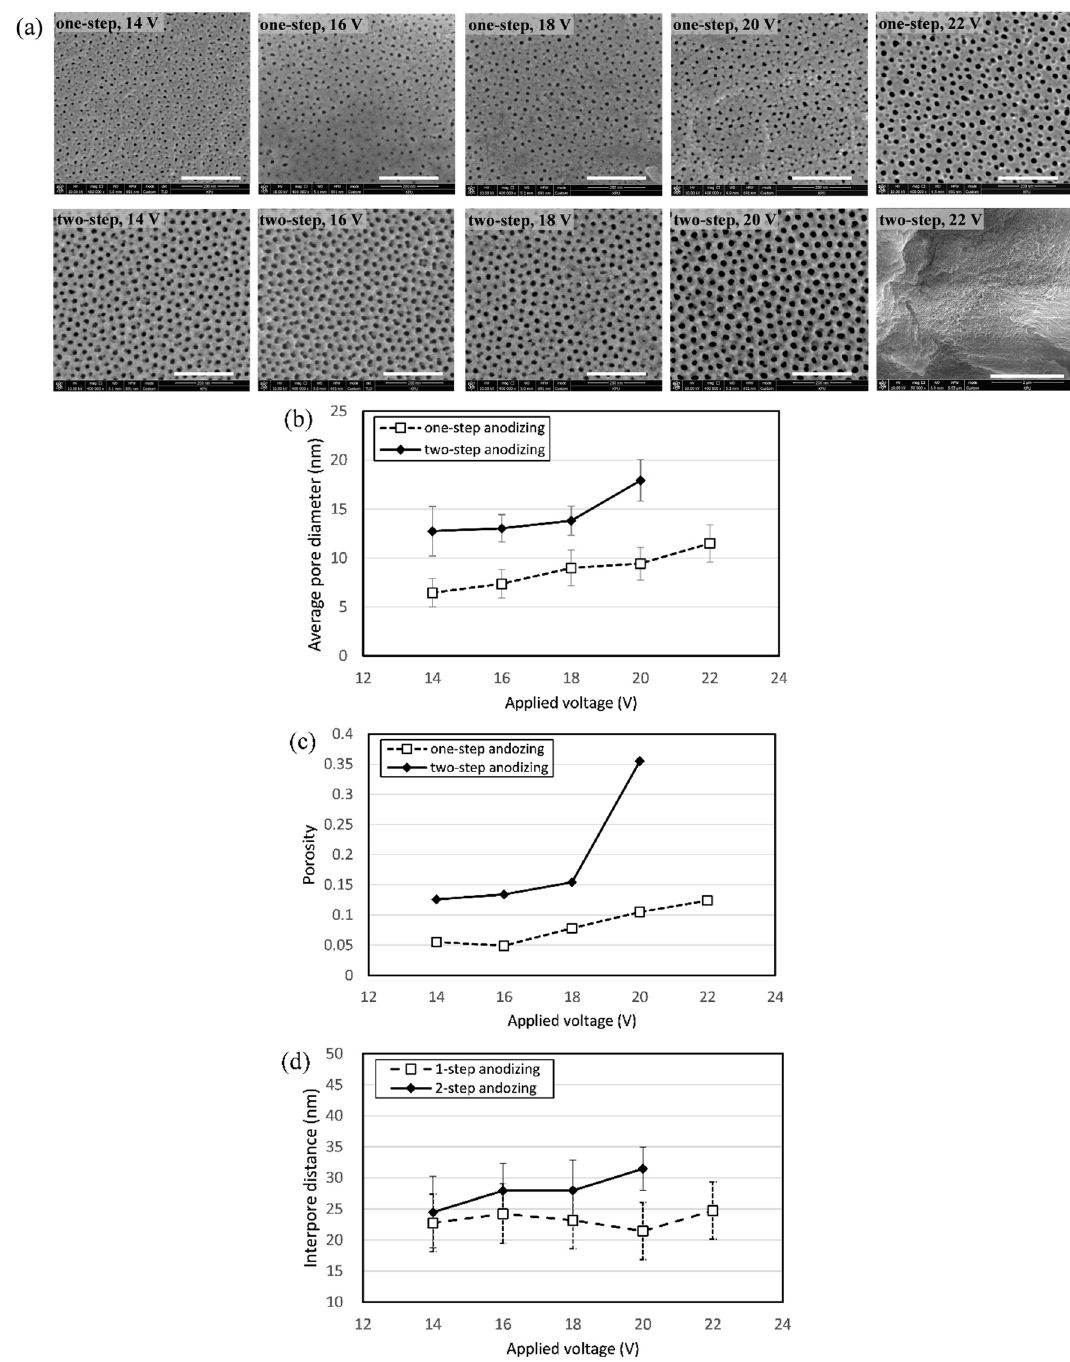
Figure 2. ( a ) SEM images of the AAO layer created by one-step and two-step anodizing at static voltages of 14, 16, 18, 20, and 22 V for 25 min (the scale bar is 200 nm for all except 2 μ m in the image of two-step, 22 V), ( b ) the corresponding change in average pore diameter, ( c ) the corresponding change in porosity, and ( d ) the corresponding change in interpore distance.